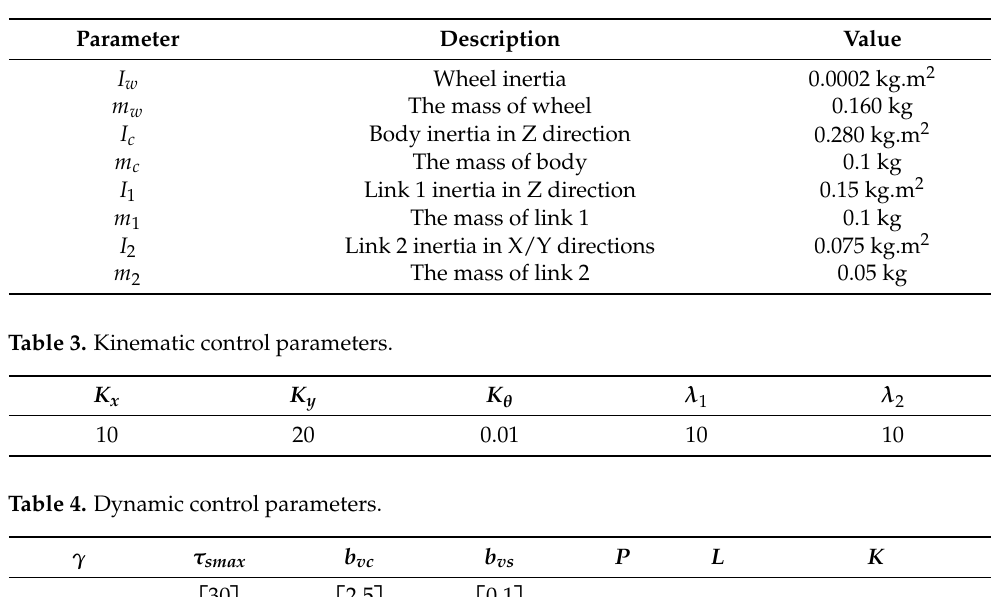
Table 2. Robot dynamic parameters.